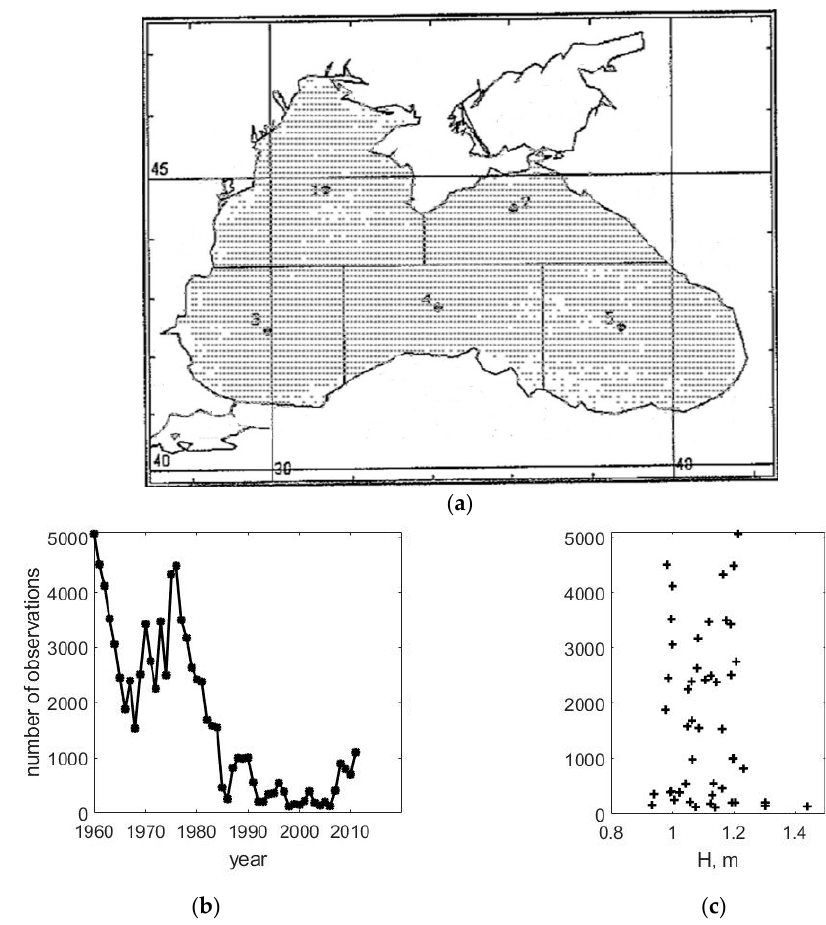
Figure 1. Distribution of observation points for period 1960–2011 along the Black Sea ( a ), the total number of observations per year ( b ), and the dependence of the average annual wave height on the number of observations ( c ).